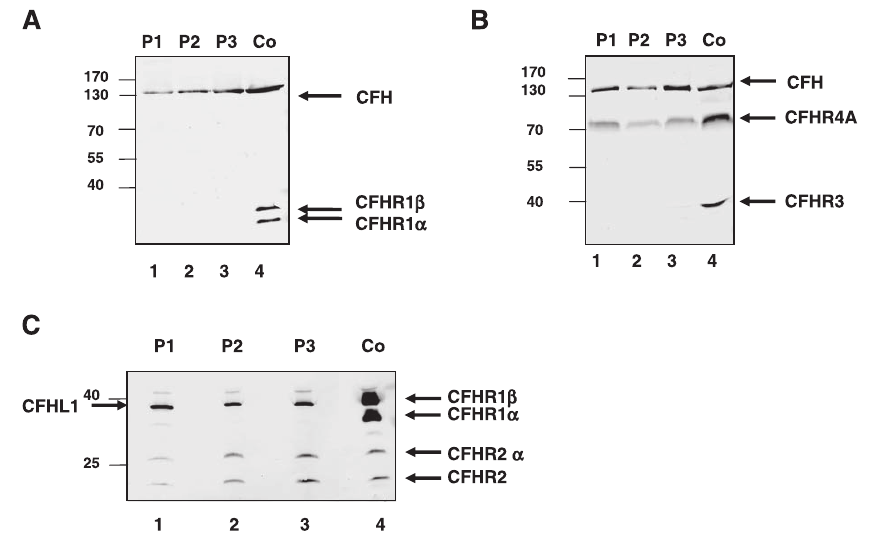
Figure 1. Deficiency of CFHR1 and CFHR3 in HUS Western blotting of serum from three HUS patients (lanes 1–3) and a control subject (lane 4). (A) Using a monoclonal antibody that reacts with the C terminus of CFHR1, complete deficiency of CFHR1 is seen in the three HUS patients. The normal control shows the two differently glycosylated forms of CFHR1 (CFHR1 a and CFHR1 b , respectively). (B) Using CFHR3 antiserum, complete deficiency of CFHR3 is seen in three HUS patients, but CFHR3 is detected in the control subject. CFHR4A is present in all samples. (C) The sera of the three HUS patients contain factor H–like protein 1 and the glycosylated and nonglycosylated forms of CFHR2 (CFHR2 a and CFHR2,